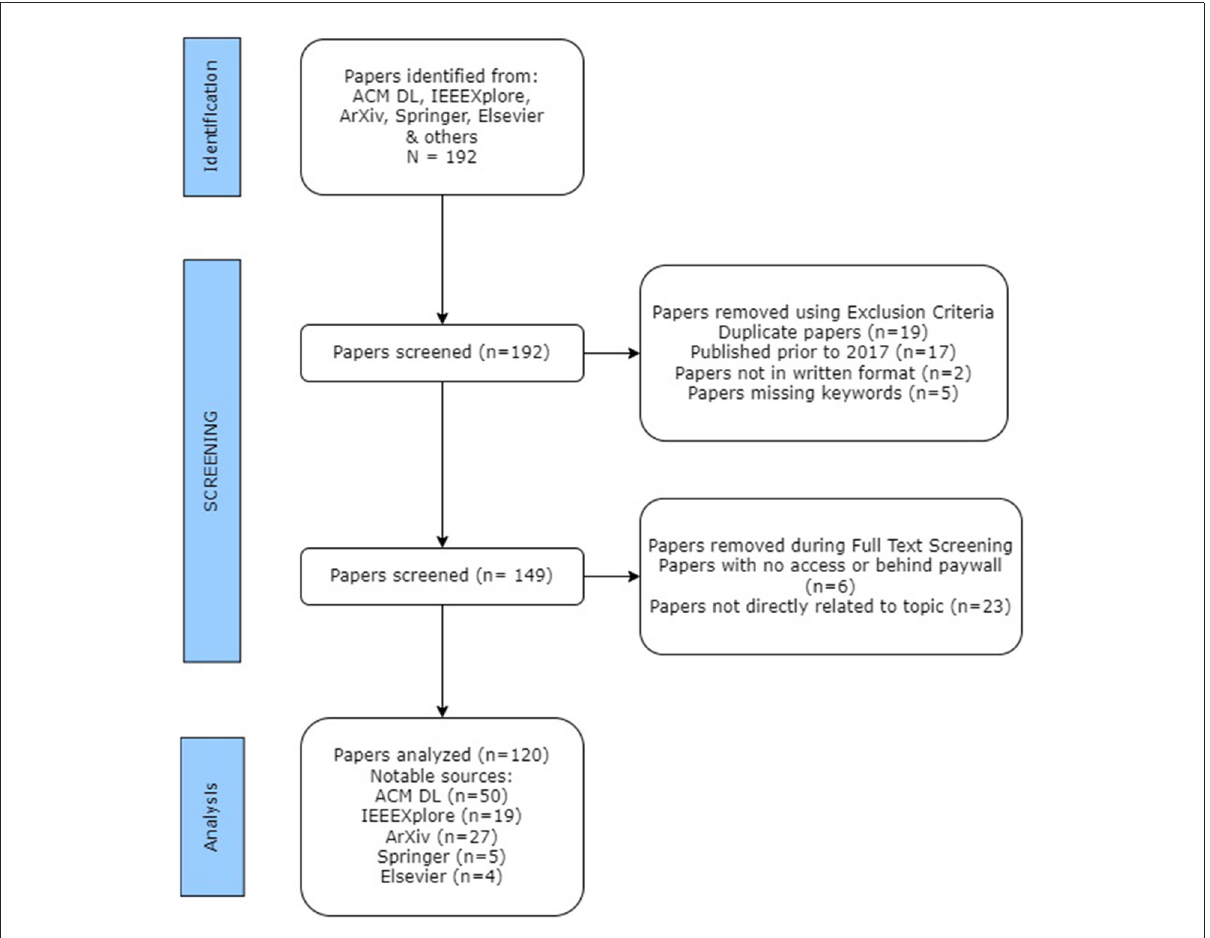
FIGURE1 A visual illustration of paper screening methodology used.